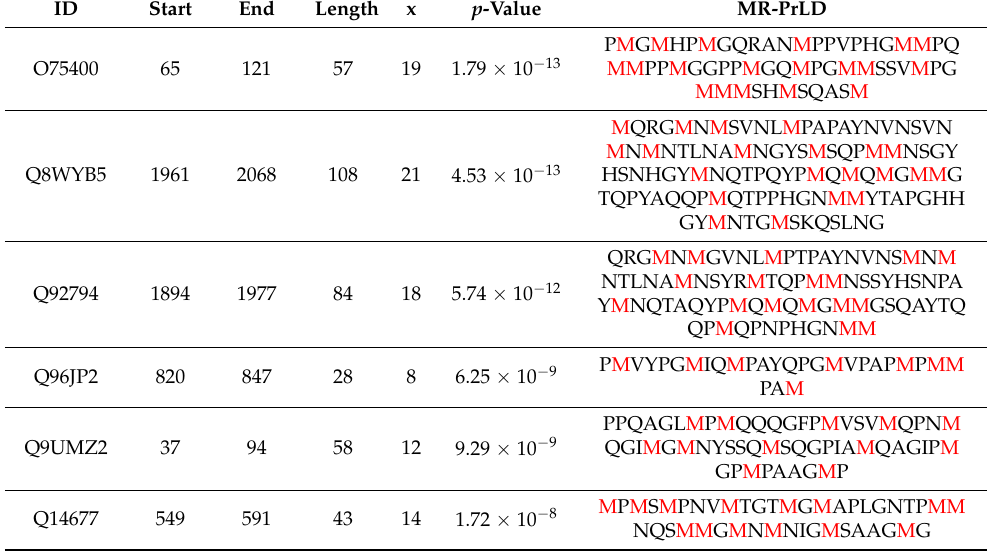
Table 1. Top-ranking MR-PrLDs according to the p -value criterion. The six top-ranking